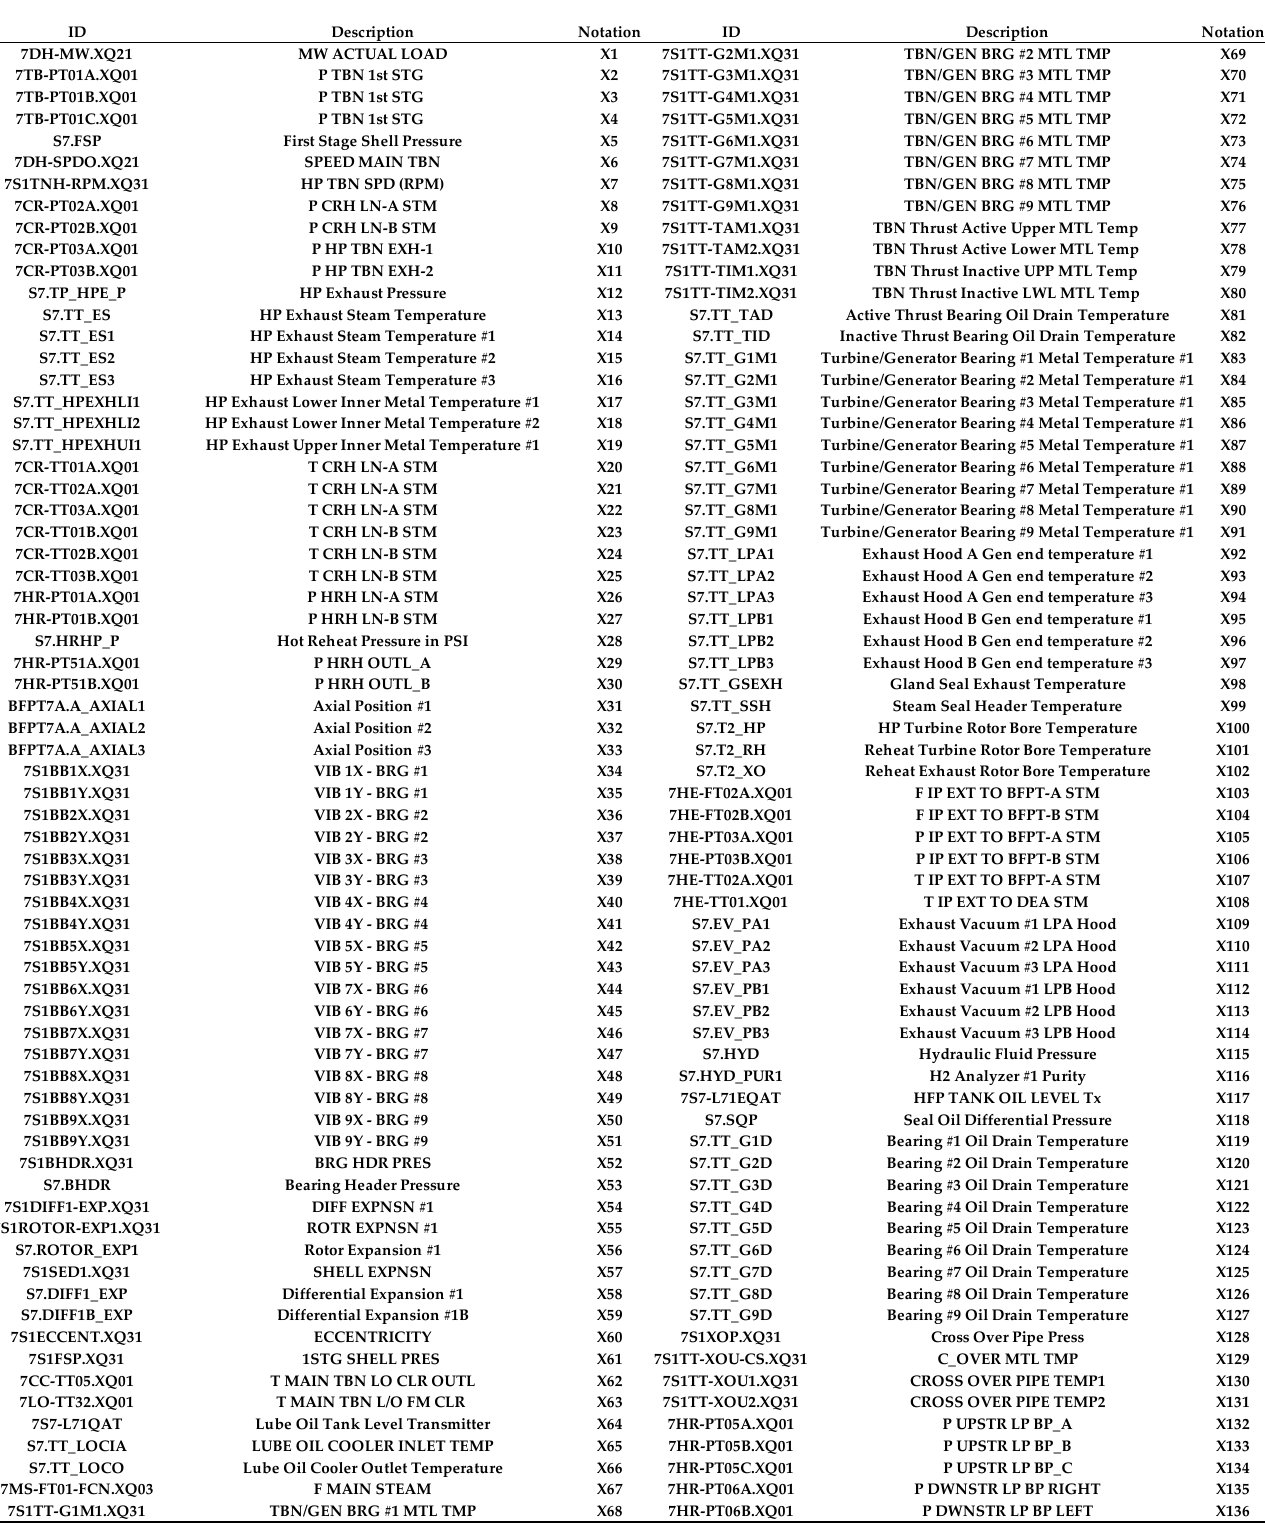
Figure A2. Summary of the sensitive sensor data from thermal power plant boiler turbine motor fault detection.